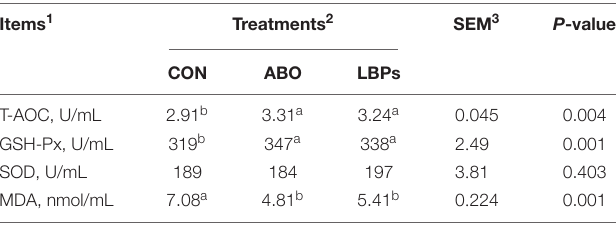
TABLE 5 | Effects of dietary LBPs supplementation on serum antioxidant activity of weaned piglets. Items 1